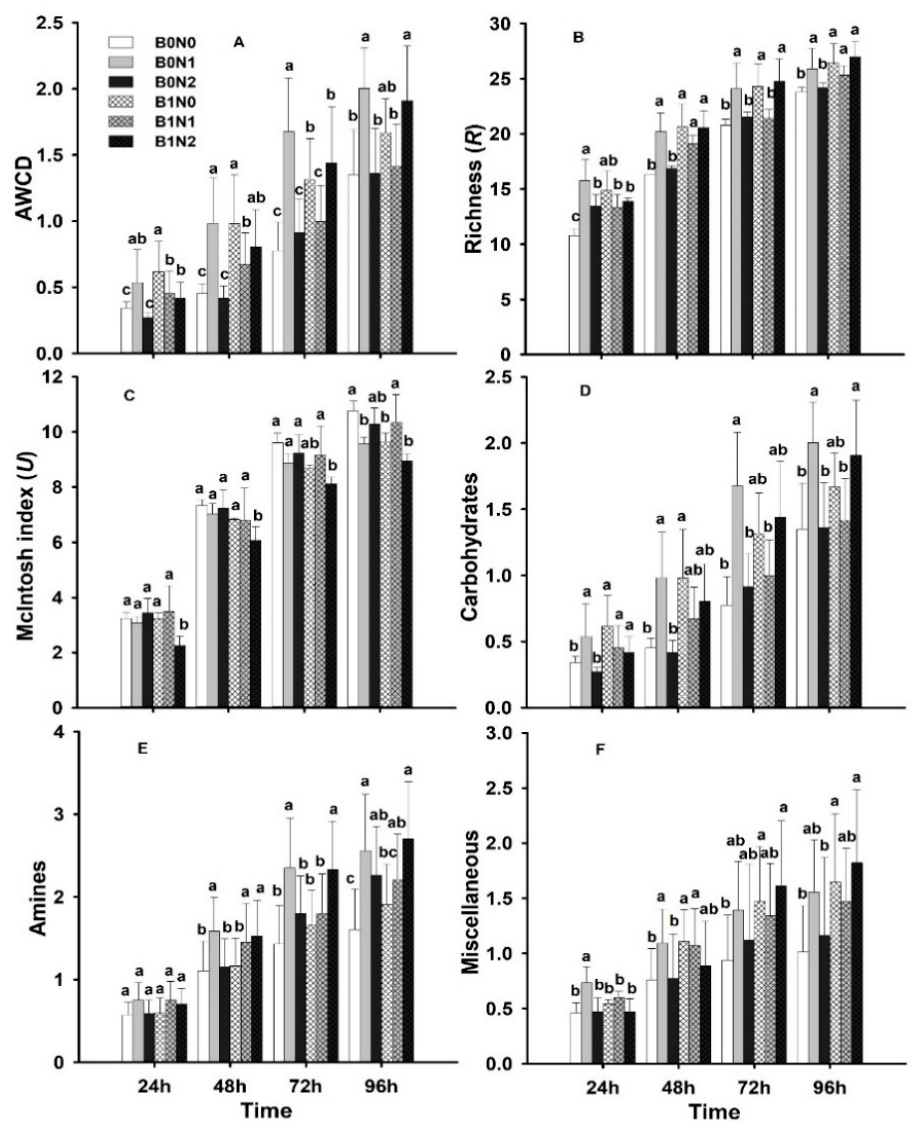
Figure 7. Effect of different treatments on soil carbon sources ( A ) Average well color development (AWCD), ( B ) Richness (R), ( C ) Mclntosh index ( U ), ( D ) Carbohydrates, ( E ) Amines, ( F ) Miscellaneous; B0N0 (without biochar or N fertilization); B0N1 (without biochar and with 160 kg·ha − 1 N); B0N2 (without biochar and with 120 kg·ha − 1 N); B1N0 (biochar 25 t·ha − 1 only); B1N1 (biochar 25 t·ha − 1 and 160 kg·ha − 1 N); B1N2 (biochar 25 t·ha − 1 and 120 kg·ha − 1 N) at different times (24, 48, 72, and 96 h). The letters a, b, c, indicate statistically significant difference at p < 0.05.